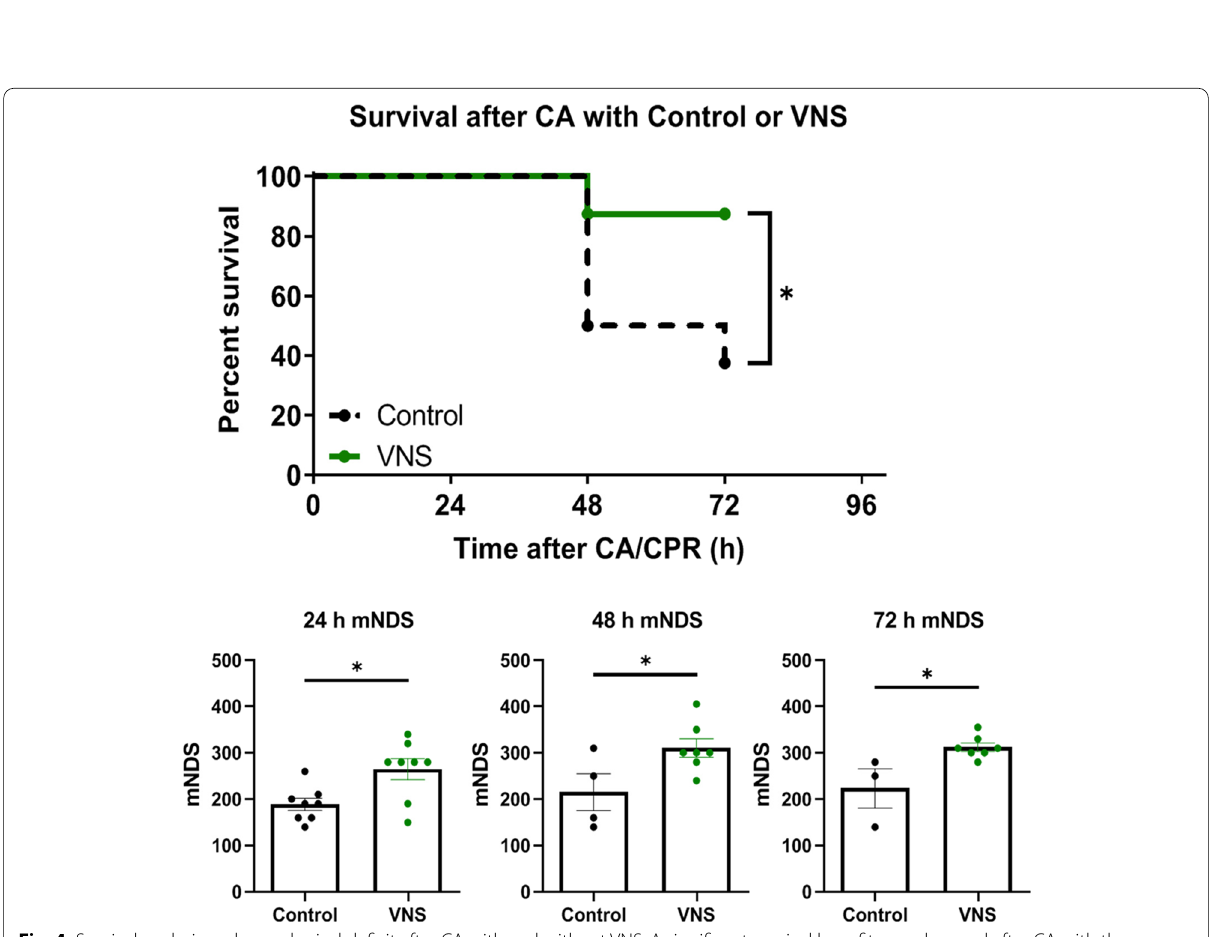
8 each. Log-Rank test was used for = modified neurological deficit =